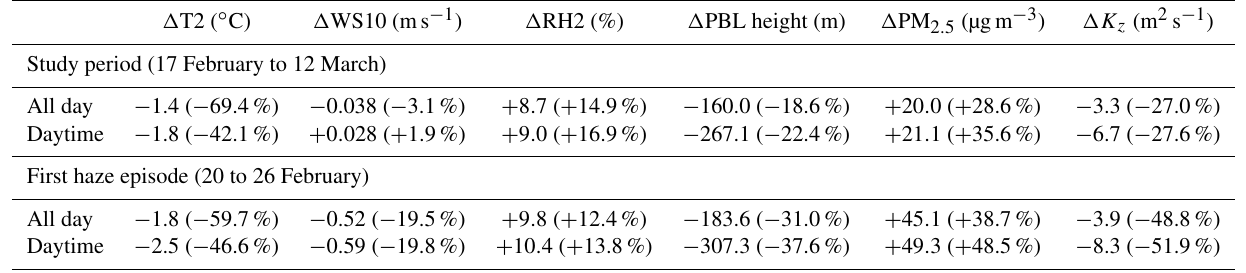
Table 5. The model-simulated feedback-induced changes (FULL minus NoAFB) in T2, WS10, RH2, PBL height, PM 2 . 5 concentration, and vertical diffusion coefficient ( K z ) averaged over the BTH region during the entire period and the first haze episode. Inside the parentheses are percentage changes relative to the NoAFB case.